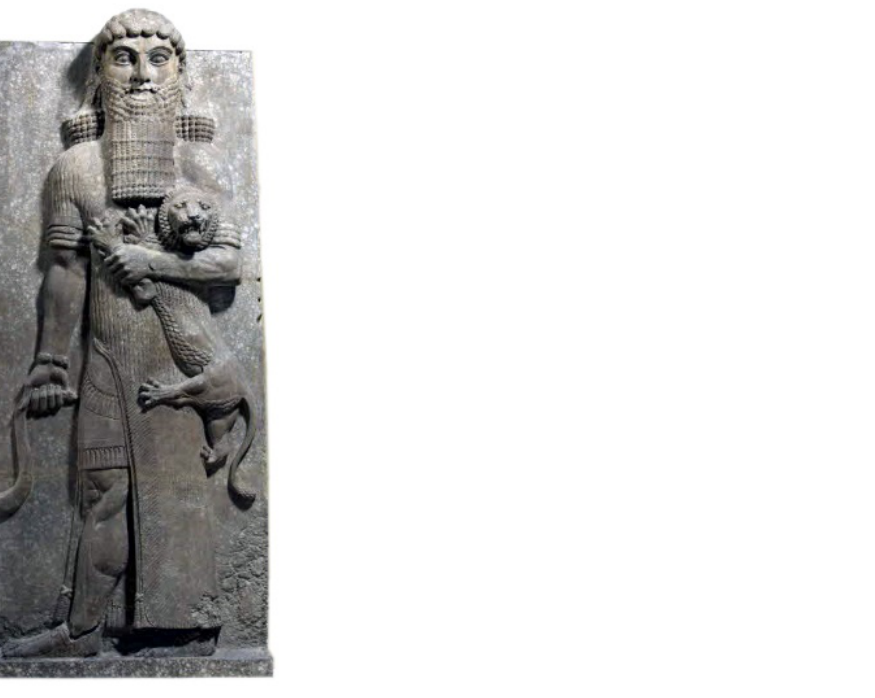
Figure 27. Hero (Gilgamesh?) Overpowering Lion (Louvre inv. no. AO 19862); sculptural relief (partial reconstruction), H. 5.5 m; Palace of Sargon II, present-day Khorsabad (mod. Iraq); Neo-Assyrian, ca. 713–705 BCE [photography by Thierry Ollivier; courtesy of the Louvre Museum, Paris].